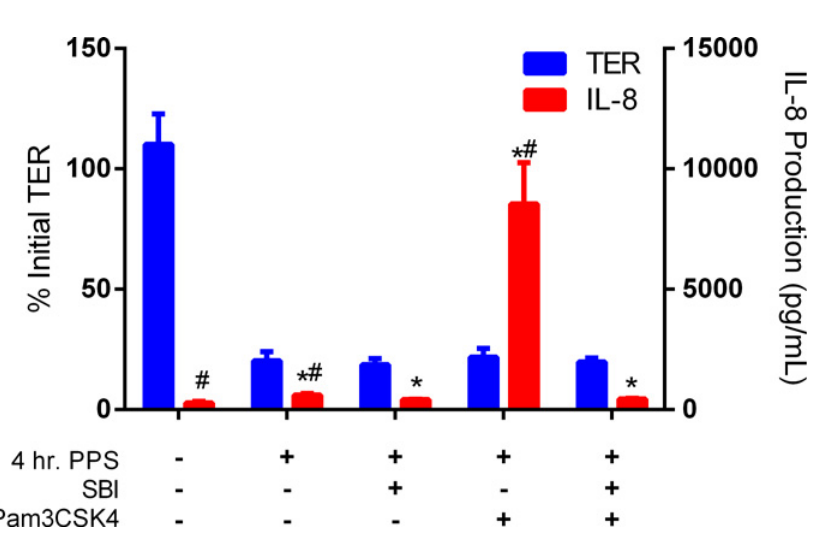
Fig 6. Steric Exclusion of Pam3CSK4 by Immunoglobulin Binding. Pam3CSK4 translocation across a PPS damaged epithelial barrier was inhibited by steric exclusion when 10 ng/mL of Pam3CSK4 was bound by the immunoglobulin in 50 mg/mL of SBI. All co-cultures were incubated with 0.01% PPS for 4 hours prior to experimentation to ensure epithelial barriers were damaged. Pam3CSK4 translocates from the apical to basal compartment across a PPS damaged epithelial barrier. Binding of Pam3CSK4 by the immunoglobulins in SBI completely inhibits antigen translocation as shown by the complete elimination of IL-8 production by basal THP-1 monocytes. * indicates P < 0.05, when comparing individual treatments with control (no treatment) IL-8 production. # indicates P < 0.05, when comparing individual treatments with 4hr. PPS + SBI IL- 8